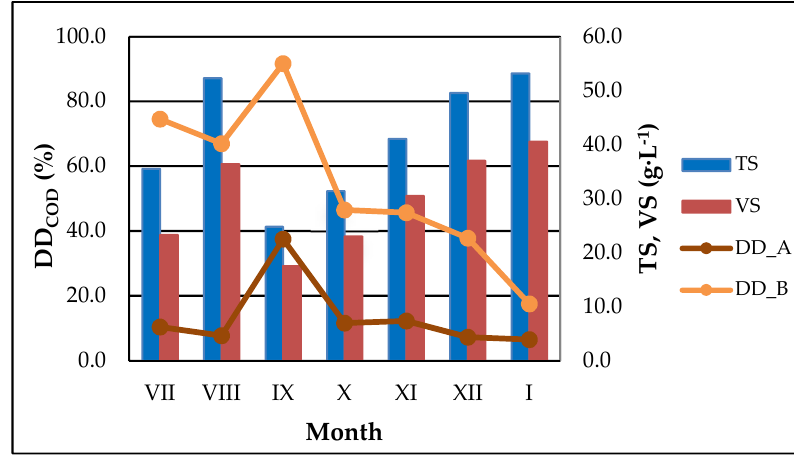
Figure 1. Evolution of disintegration degree (DD COD ) vs total solids (TS) and volatile solids (VS) content of waste activated sludge (WAS).